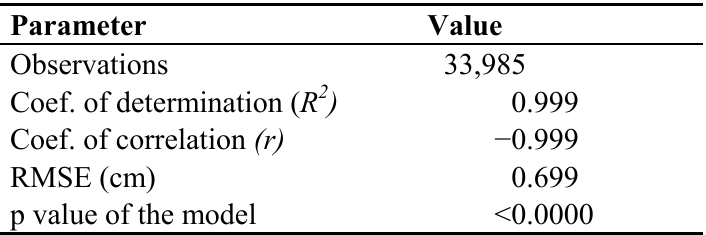
Table 3. Summary of the fitted linear model to estimate distances to an artificial target from the sensor output in laboratory conditions.